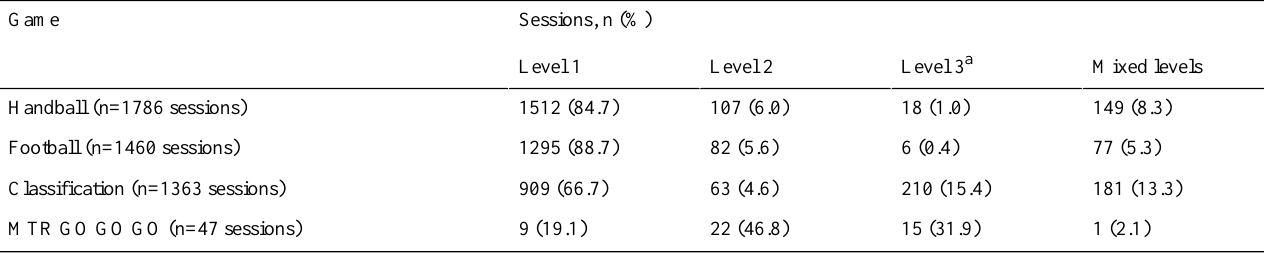
Table 6. Difficulty levels of some virtual reality games played in the 1906